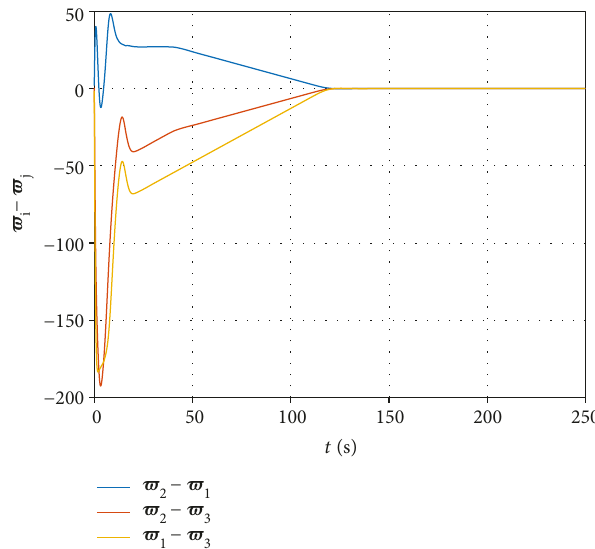
Figure 6: System coordinate path parameters error evolution.